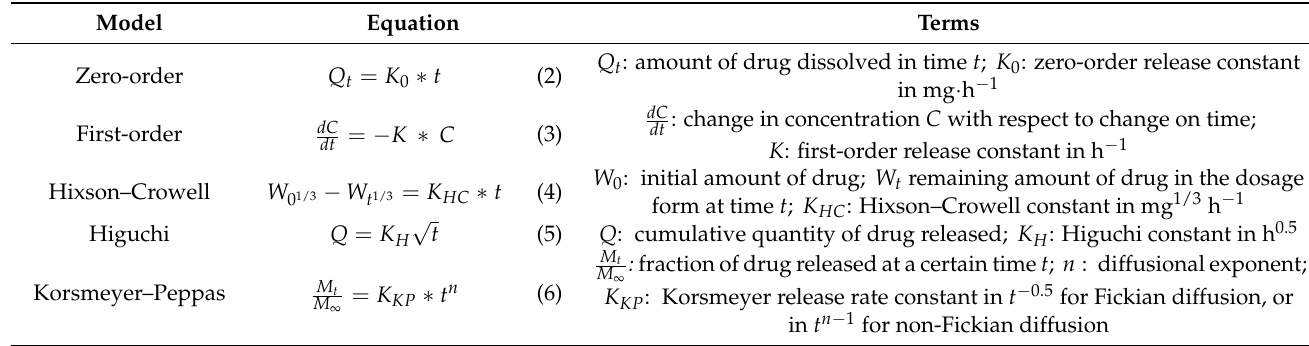
Table 2. Kinetic models for drug